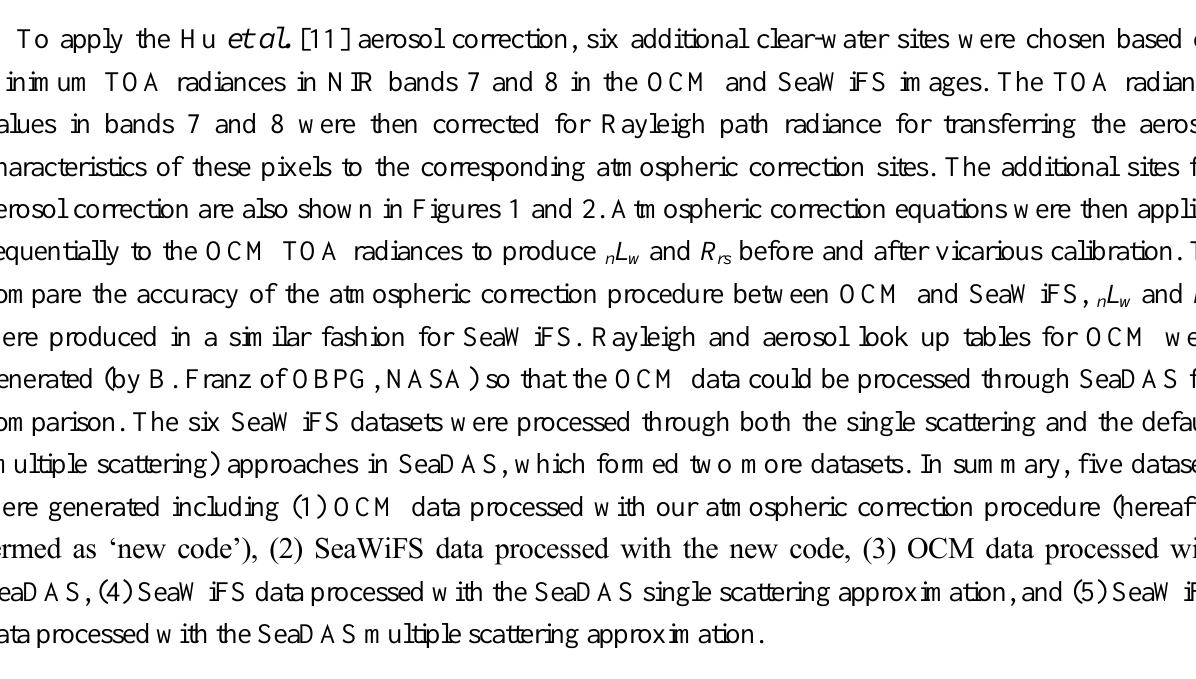
Table 1. Comparison of OCM and SeaWiFS attributes and geometries at the six atmospheric correction sites on the six